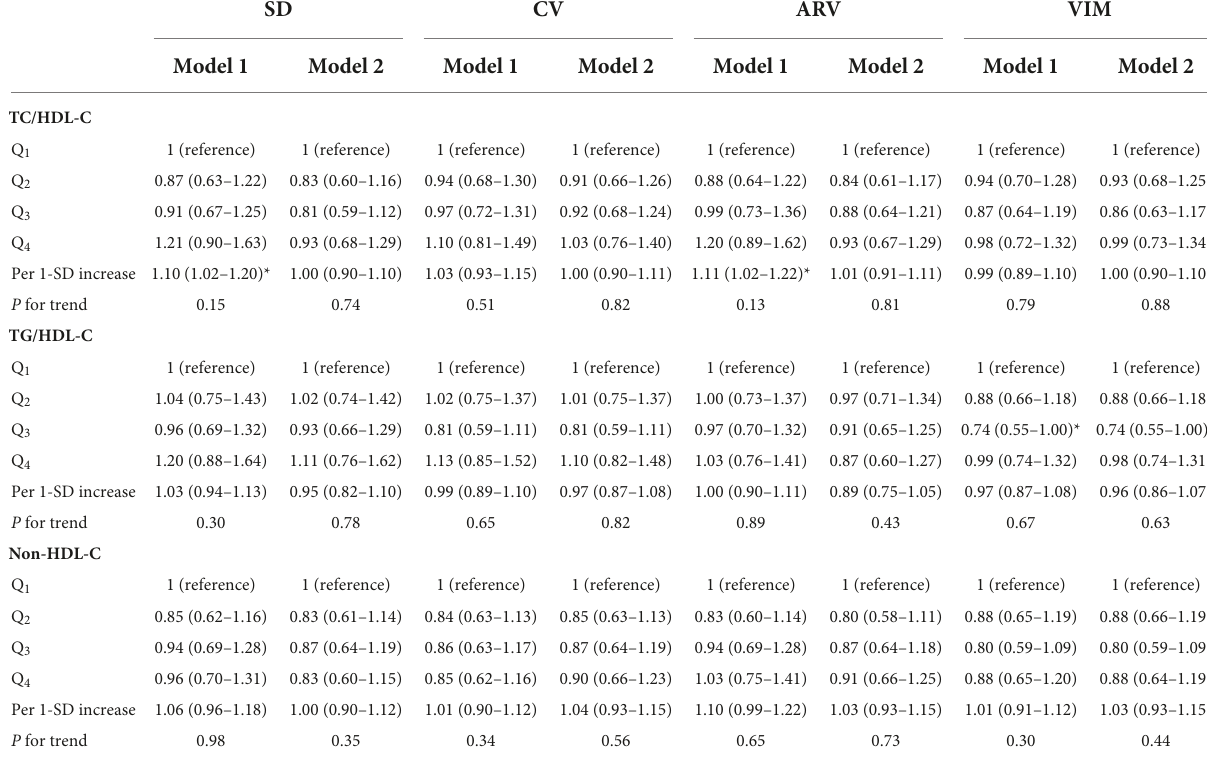
TABLE 3 Hazard ratios and 95% CI of incident CVD for TC/HDL-C, TG/HDL-C, and non-HDL-C variability: Tehran Lipid and Glucose